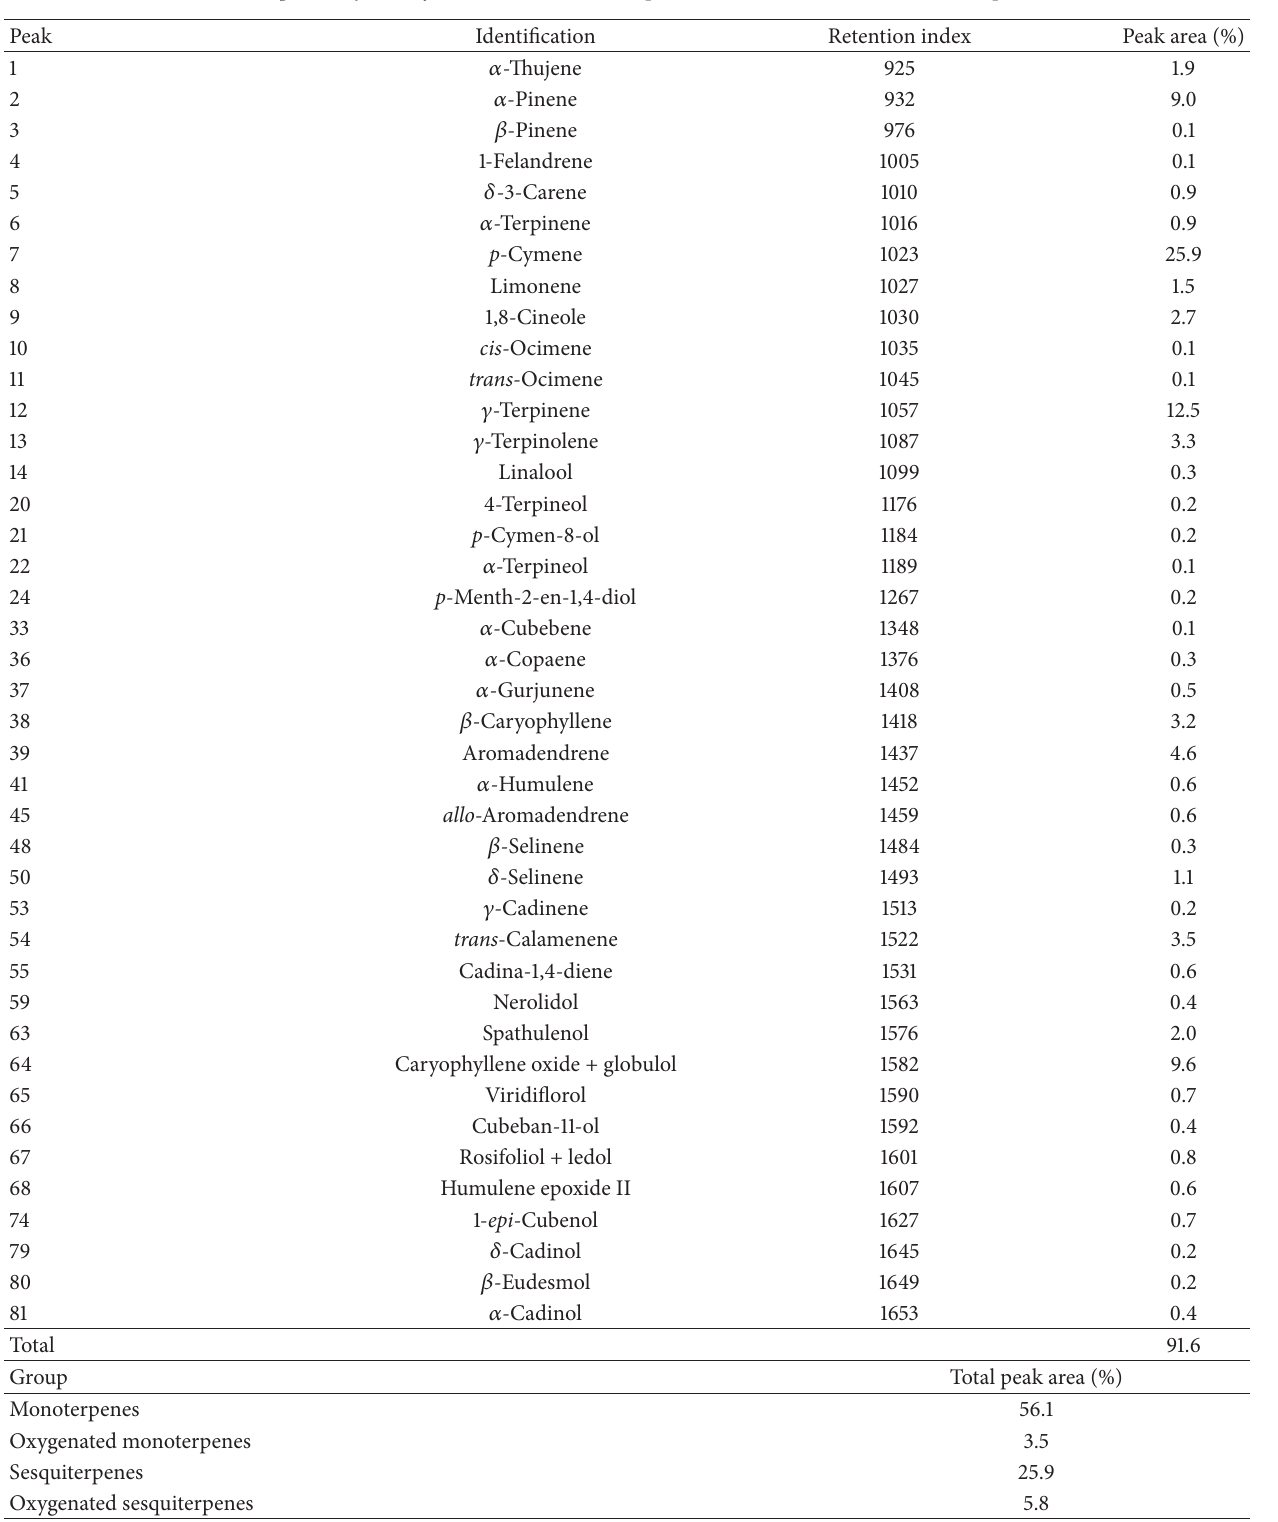
Table 2: Blepharocalyx salicifolius EOs chemical compounds, retention indices, and relative peak area.